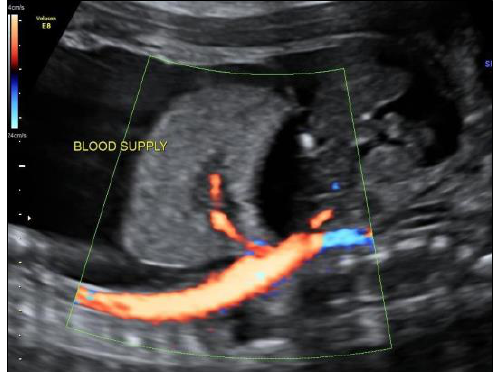
Figure 1: Ultrasound image of BPS with severe NIH